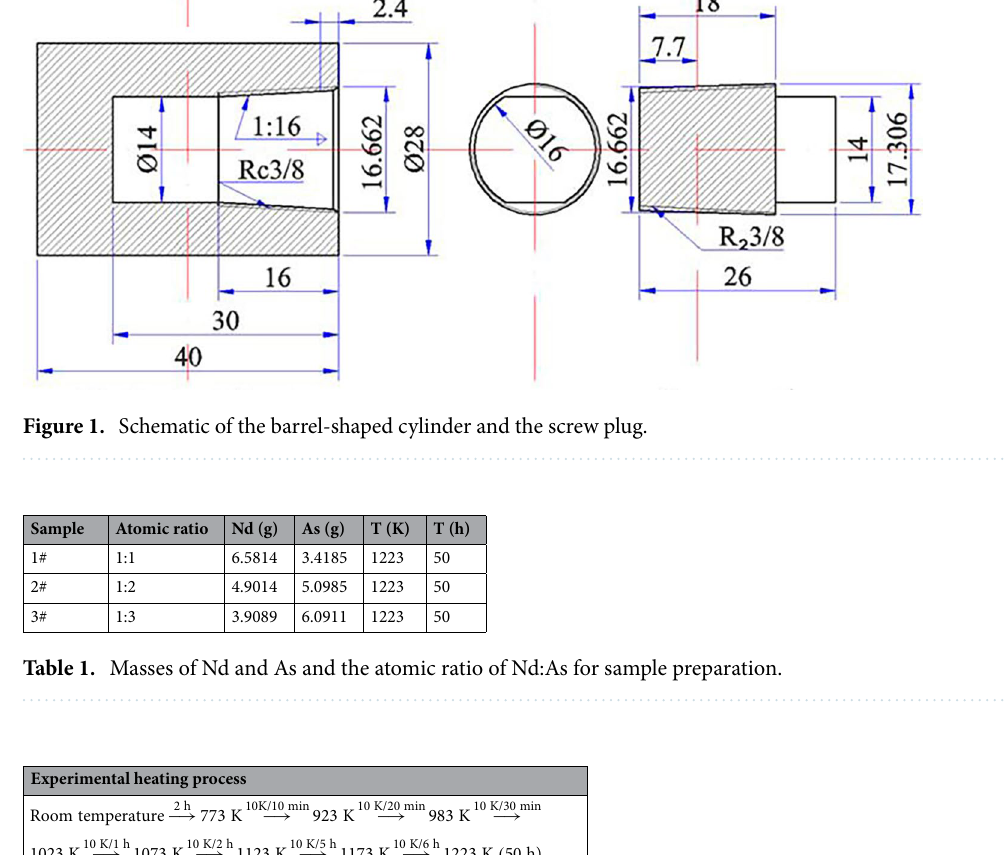
Table 2. Experimental heating process.